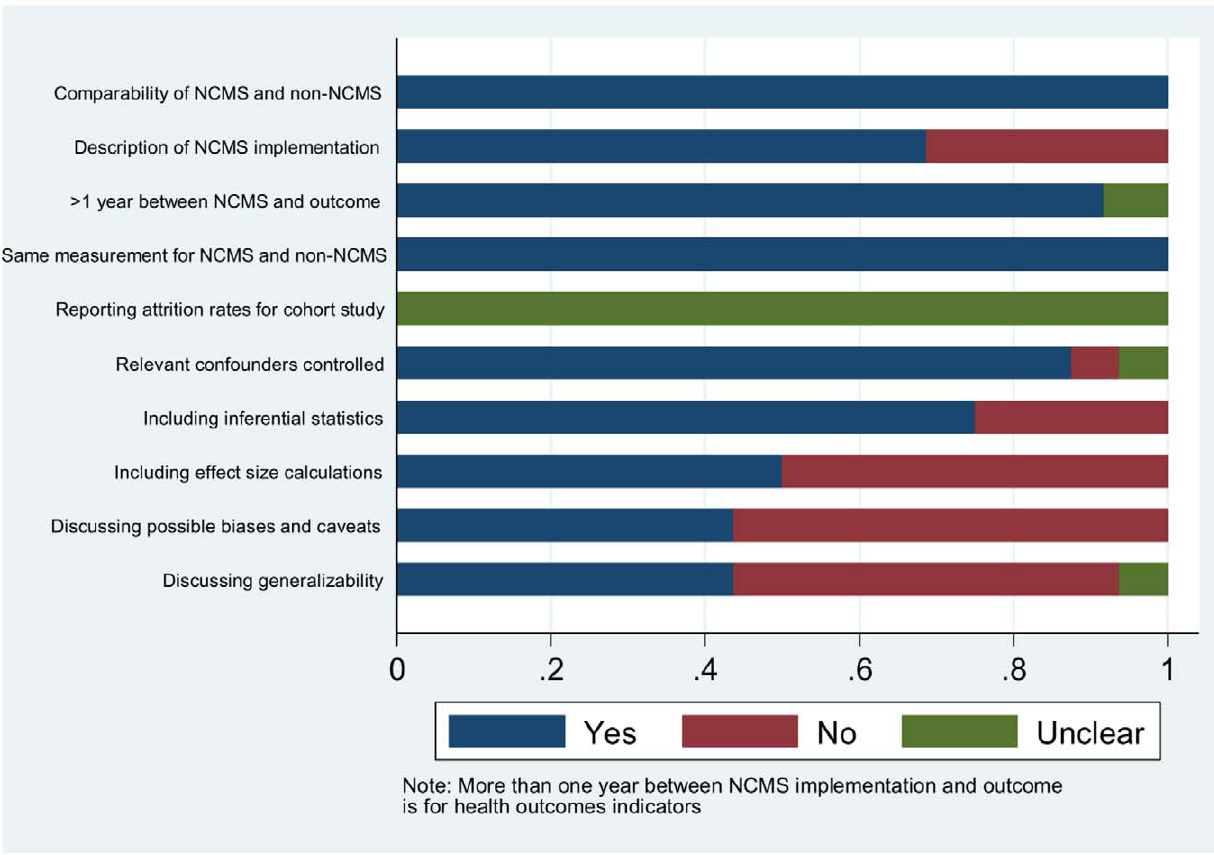
Figure 3. Quality assessment for included literatures.